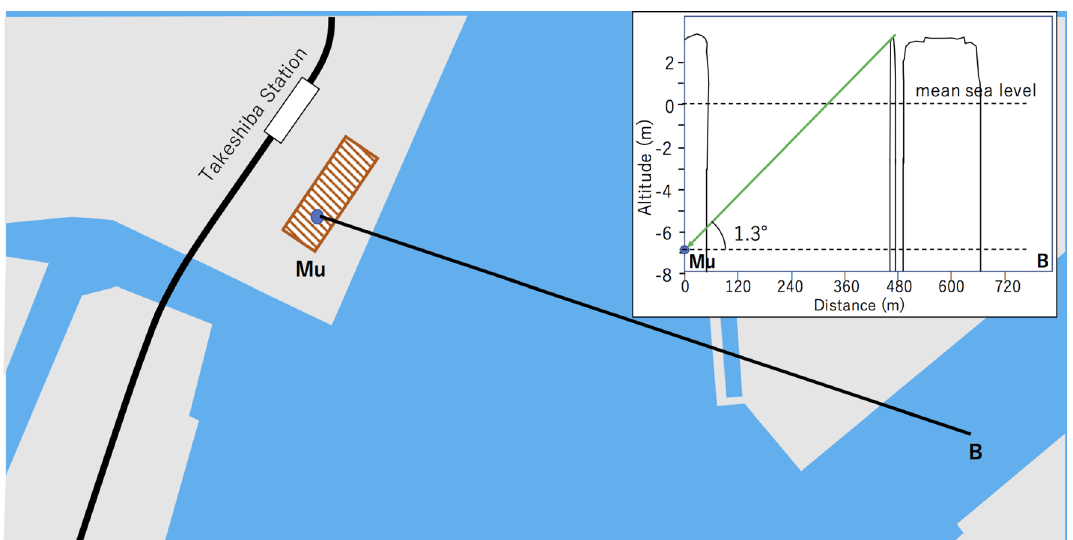
Figure 7. Enlarged map near the region of (2) in Fig. 4. The red shaded rectangle indicates a commercial building having a basement floor located 10 m below the ground surface. The label Mu indicates the location of the HKMSDD-MSM. The inset shows the cross-sectional view along the Mu-B line as an example of the vertical cross-sectional configuration of the measurement. The elevation scale is magnified by 50 times compared to the horizontal scale. HKMT drew this map with Microsoft PowerPoint software and holds the